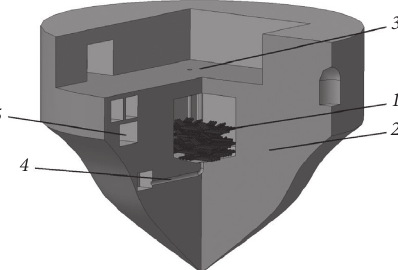
Figure 3: Appearance of storages located in rock mines:1, graphite radioactive waste; 2, rock massif; 3, inspection system; 4, drainage system; 5, auxiliary